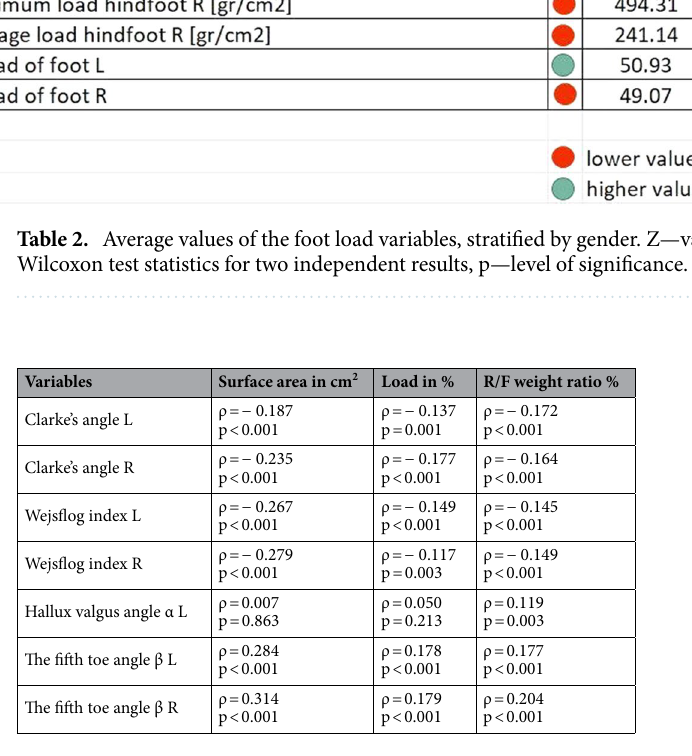
Table 3. Associations between the forefoot load and morphological features of the feet.